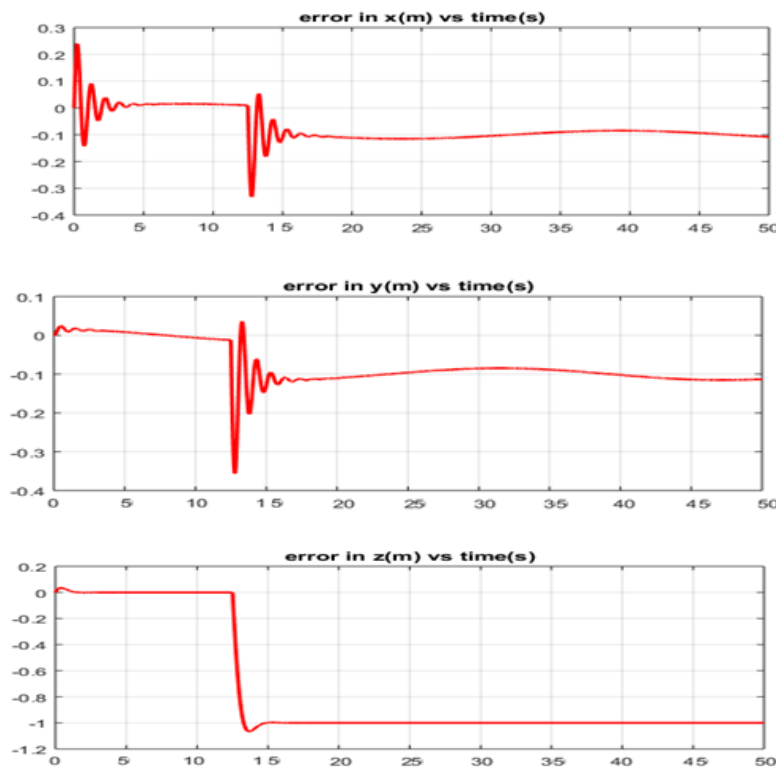
Figure 21. Position error rates while maneuvering using MFSDF-SMC.